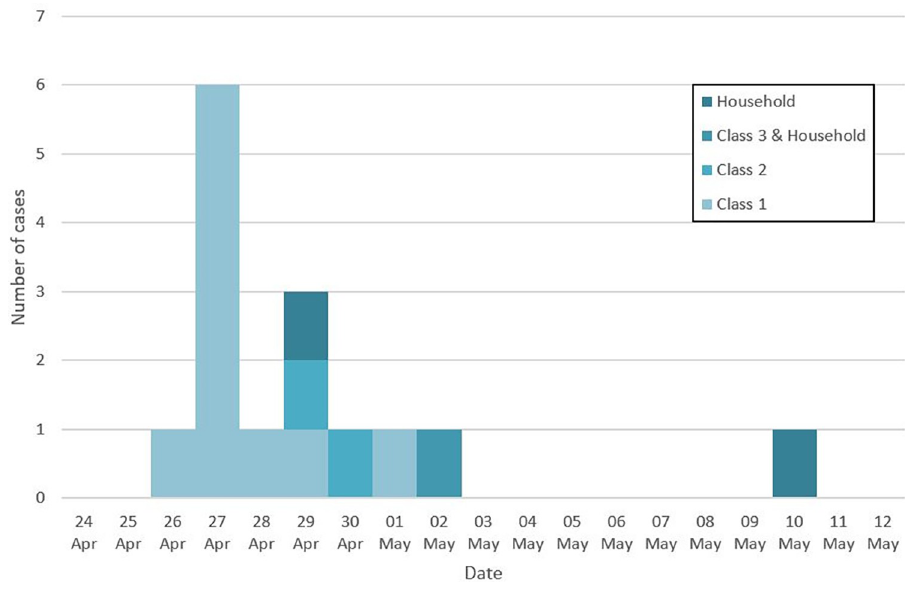
Fig 1. Epidemic curve of cases confirmed by positive RDT or RT-PCR (n = 15), school outbreak, Geneva, Switzerland, 2021. Apr: